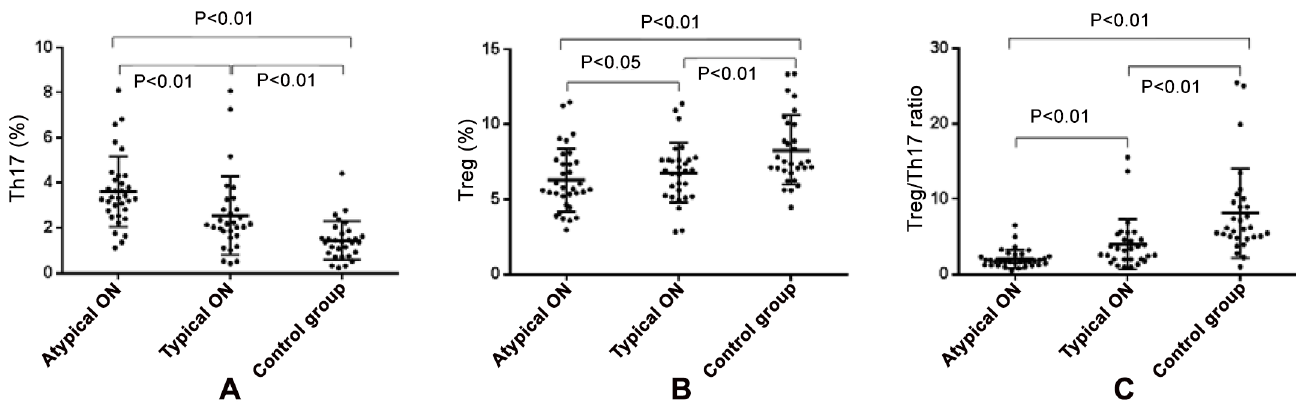
Fig 2. A. The percentage of CD3+CD4+IL-17A+ Th17 cells in patients with atypical ON (left) or typical ON (middle), and from control subjects (right). The percentage of Th17 cells was higher in atypical ON patients than in typical ON patients ( P < 0.01) and controls ( P < 0.01). The percentage of Th17 cells in patients with typical ON was significantly higher than in control subjects ( P < 0.01). B. The percentage of CD4+CD25+FoxP3+ Treg cells in patients with atypical ON (left) or typical ON (middle), and from control subjects (right). The percentage of Treg cells was significantly lower in atypical ON patients or patients with typical ON than in controls (both P < 0.01). The number of Treg cells did not statistically differ between patients with typical ON compared to atypical ON patients ( P > 0.05).C. The ratio of Th17/Treg lymphocytes in patients with atypical ON (left) or typical ON (middle), and from control subjects (right). Atypical ON patients had significantly lower ratios of Treg/Th17 than patients with typical ON ( P < 0.01). The Treg/Th17 ratio was significantly lower in both patient groups than in control subjects ( P < 0.01 for both